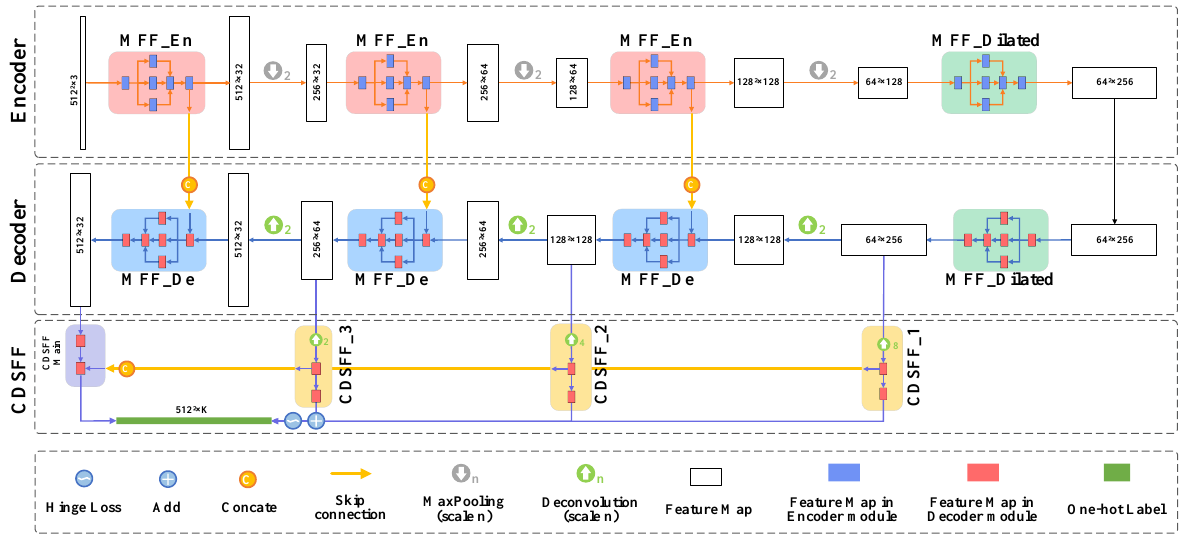
Figure 1. The architecture of CSD-Net. The number on the blocks indicates the size of the feature maps, with K denoting the number of anticipated categories.